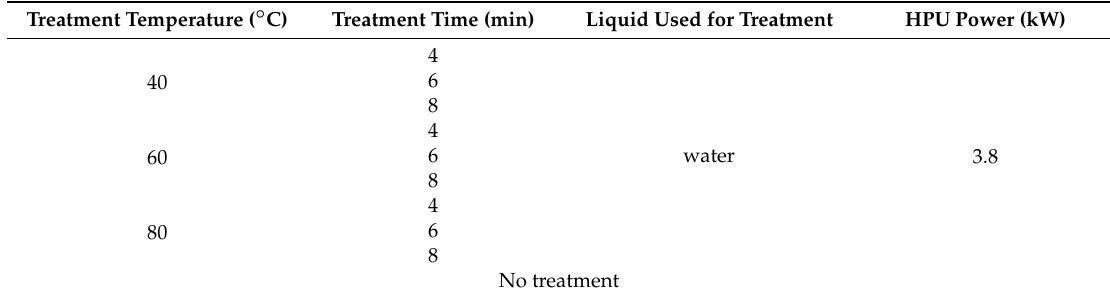
Table 1. Operating condition testing and experimental